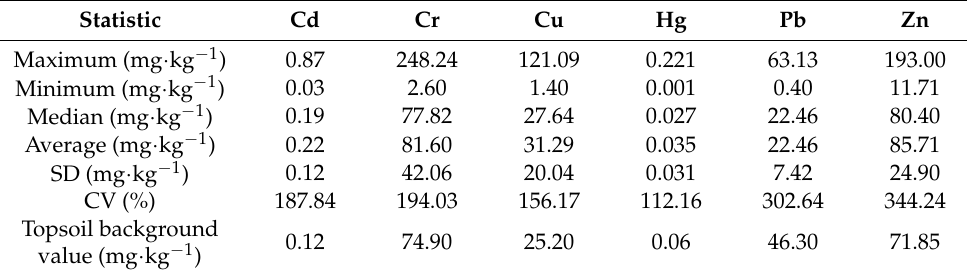
Table 5. Statistics for six heavy metals in topsoil of study